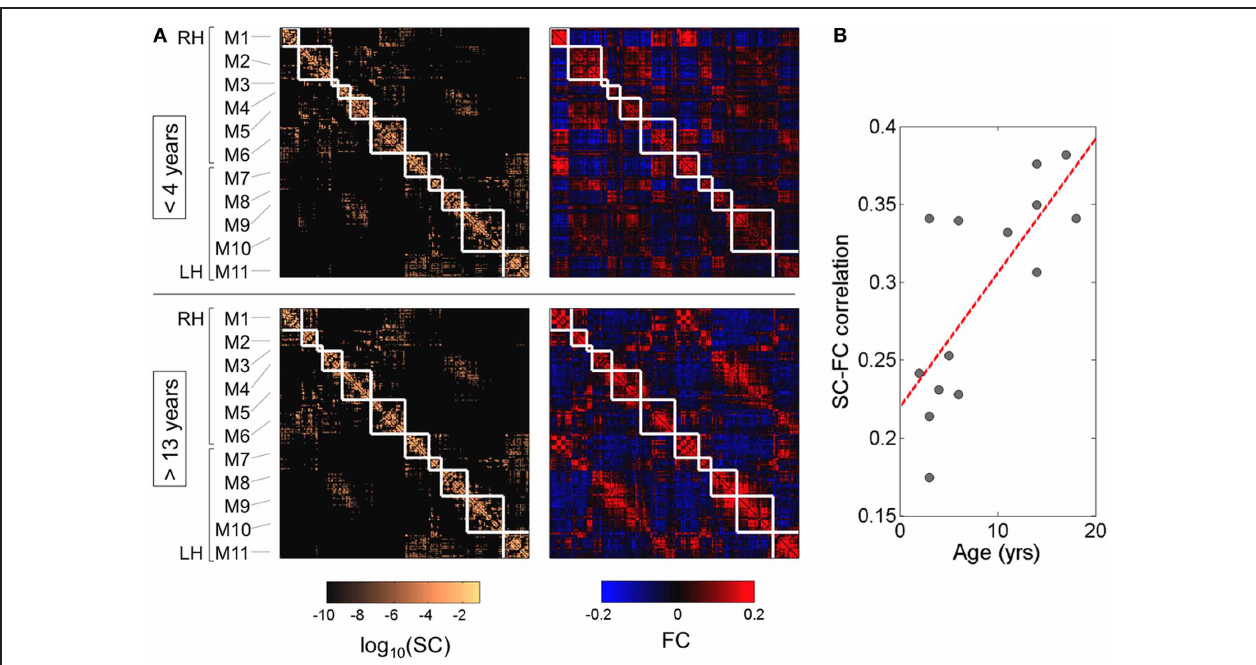
FIGURE 4 | Modularity and structure-function correlation. (A) Cortical ( N = 241) structural and functional connectivity matrices averaged over young ( < 4 years) and older ( > 13 years) subjects. Structural modules are delineated by the superimposed white grid. While modules are highly conserved (normalized mutual information = 0.82), there is a notable increase in structure-function correspondence from younger to older brains. Modules